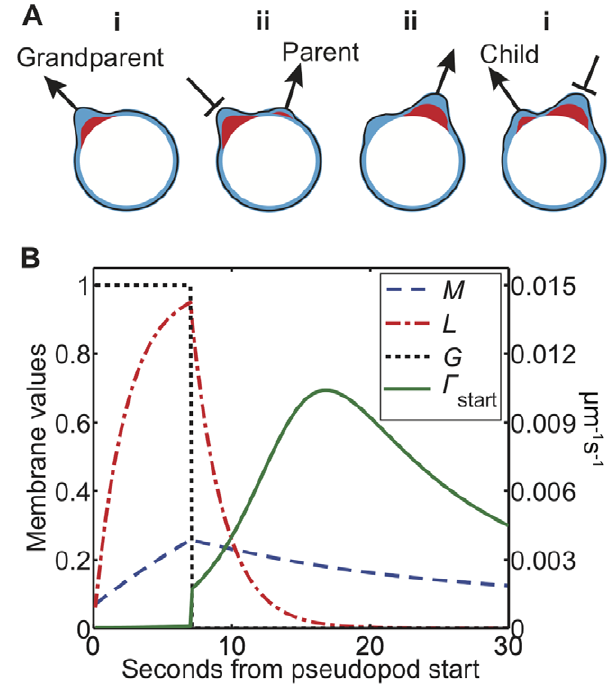
Figure 1. The excitable cortex and memory model. A) A sequence of three pseudopods. (i) As the first pseudopod (the grandparent) grows it generates memory (blue) and a local inhibitor (red). (ii) After some time the pseudopod stops growing and another (the parent) starts elsewhere. (iii) When the second pseudopod stops, the local inhibition at the site of the first has decayed but some memory remains. (iv) Therefore, the third pseudopod (the child) is more likely to form in the vicinity of the first, thus completing a zig-zag sequence. B) Time course of local membrane variables at the center of a simulated pseudopod. The variables shown are cortical memory M (dashed blue), local inhibitor L (dash-dotted red), global inhibitor G (dotted black), and pseudopod production rate C start (solid green). The rate of pseudopod formation is in m m 2 1 s 2 1 , while M and L are shown in units of units of k 0 z k 1 ð Þ t M and k L t L , respectively.